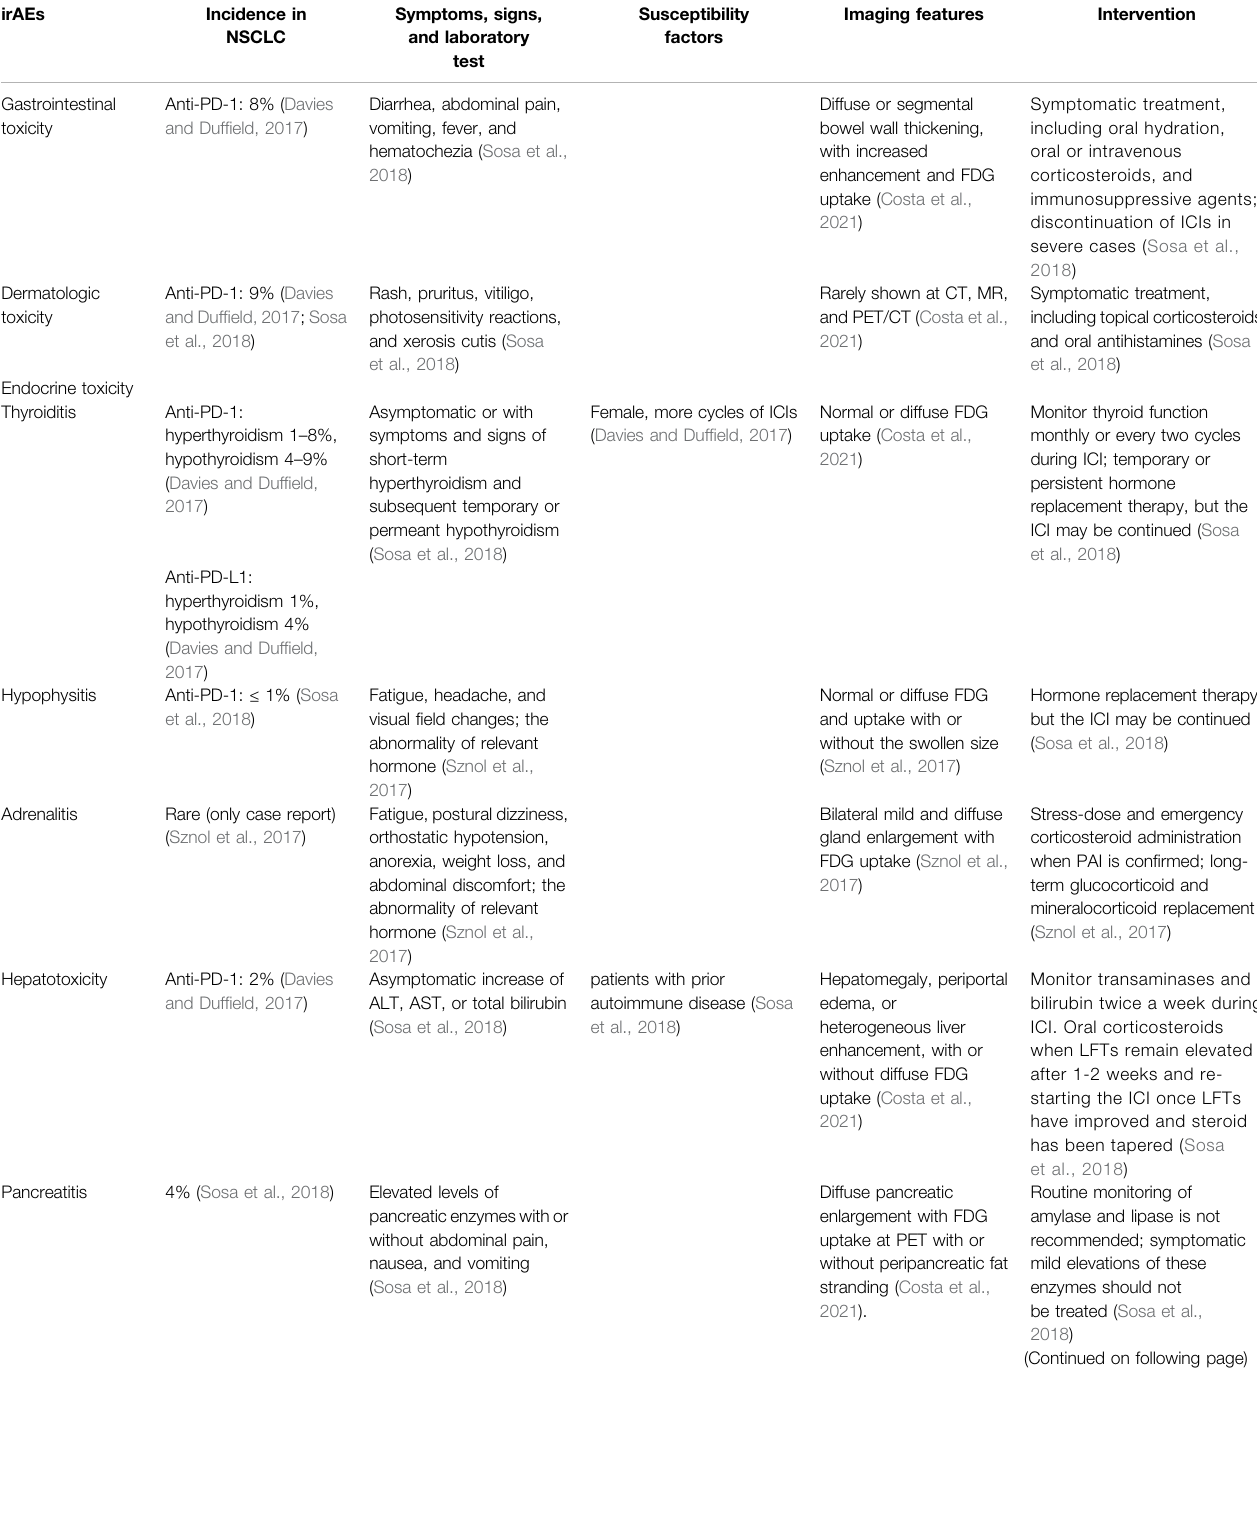
TABLE 1 | Common immune-related adverse